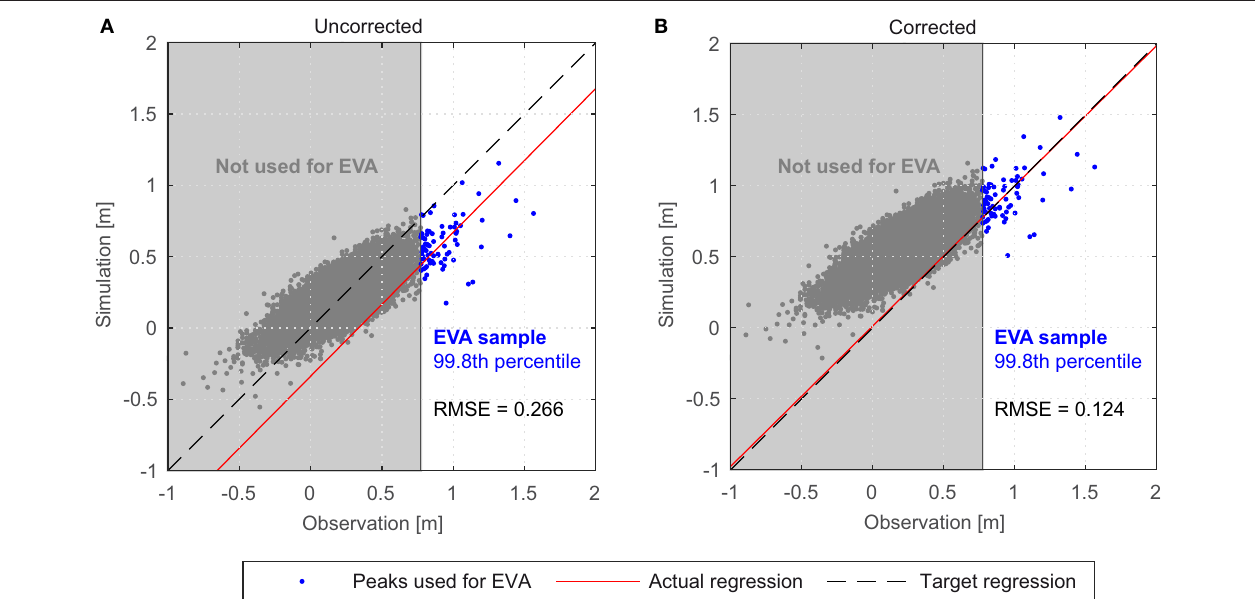
FIGURE 4 | Uncorrected water levels (A) and corrected water levels after the parametric bias correction (B).